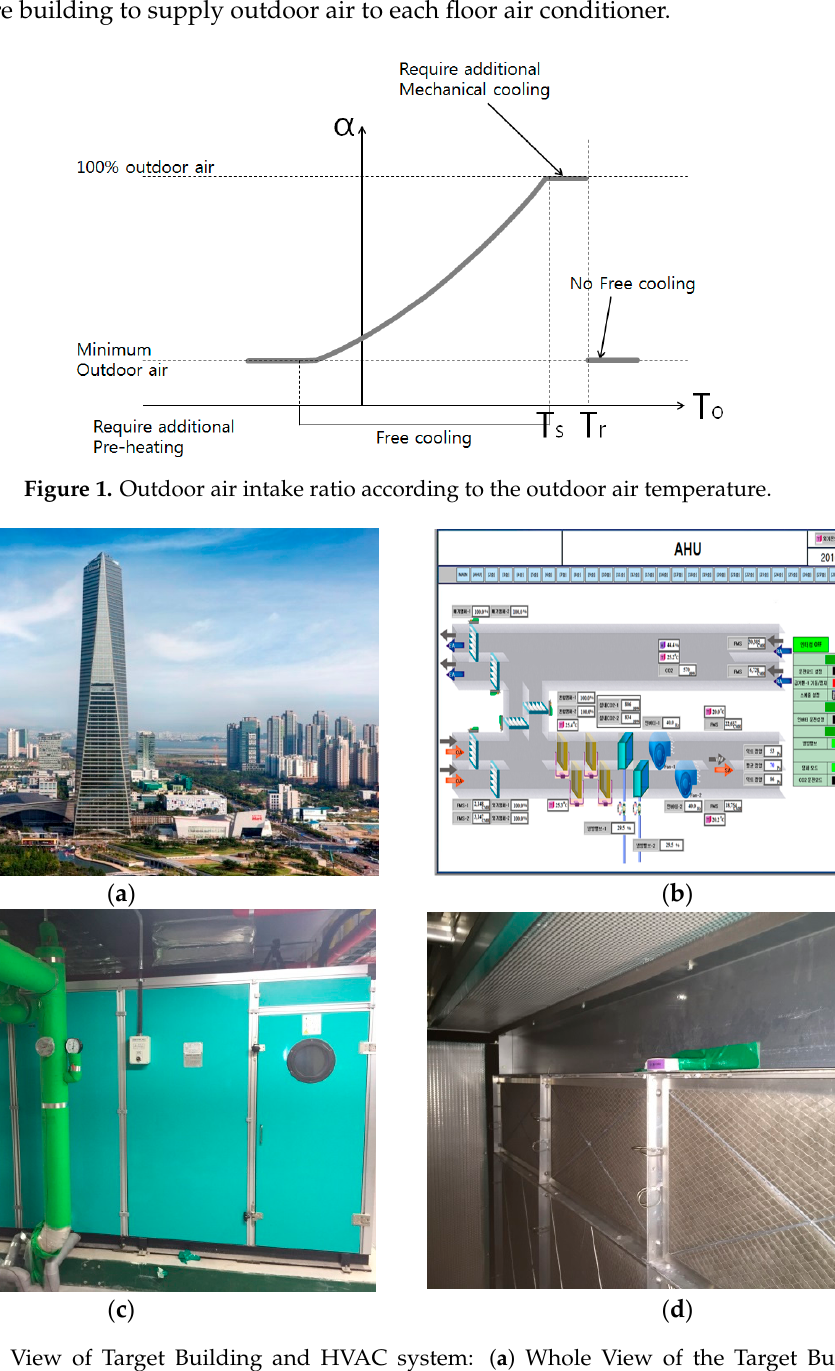
Figure 2. View of Target Building and HVAC system: ( a ) Whole View of the Target Building; ( b ) Building Automation System (BAS) Monitoring of the Target Building; ( c ) Target Building’s Air Handling Unit (AHU); ( d ) Field Measurements of Mixed Temperature.